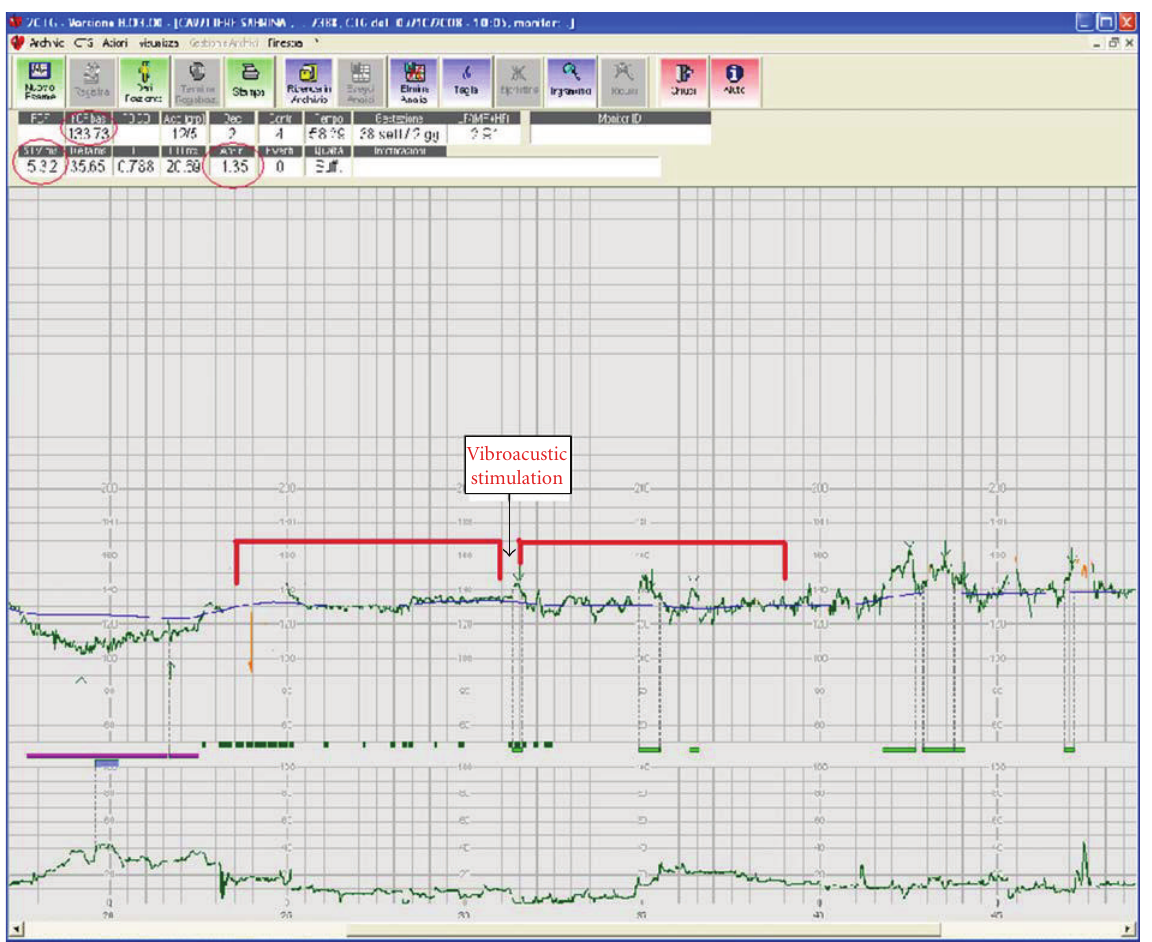
Figure 1: Example of computerized analysis of fetal heart rate tracing.